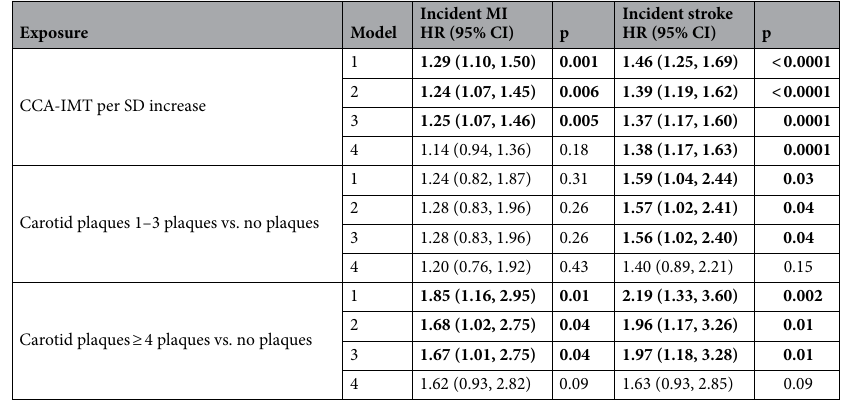
Table 3. Association between carotid measures of intima-media thickness and plaques at baseline and risk of incident myocardial infarction and stroke. Significant associations are shown in bold font. Model 1 adjusted for age and sex; Model 2 adjusted for model 1 + baseline values of body mass index, smoking status, alcohol consumption, sedentary lifestyle, hypertension and type 2 diabetes; Model 3: model 2 + APOE allele status; Model 4: model 3 + low-density lipoprotein and high-density lipoprotein cholesterol. CCA-IMT common carotid artery intima-media thickness, SD standard deviation.